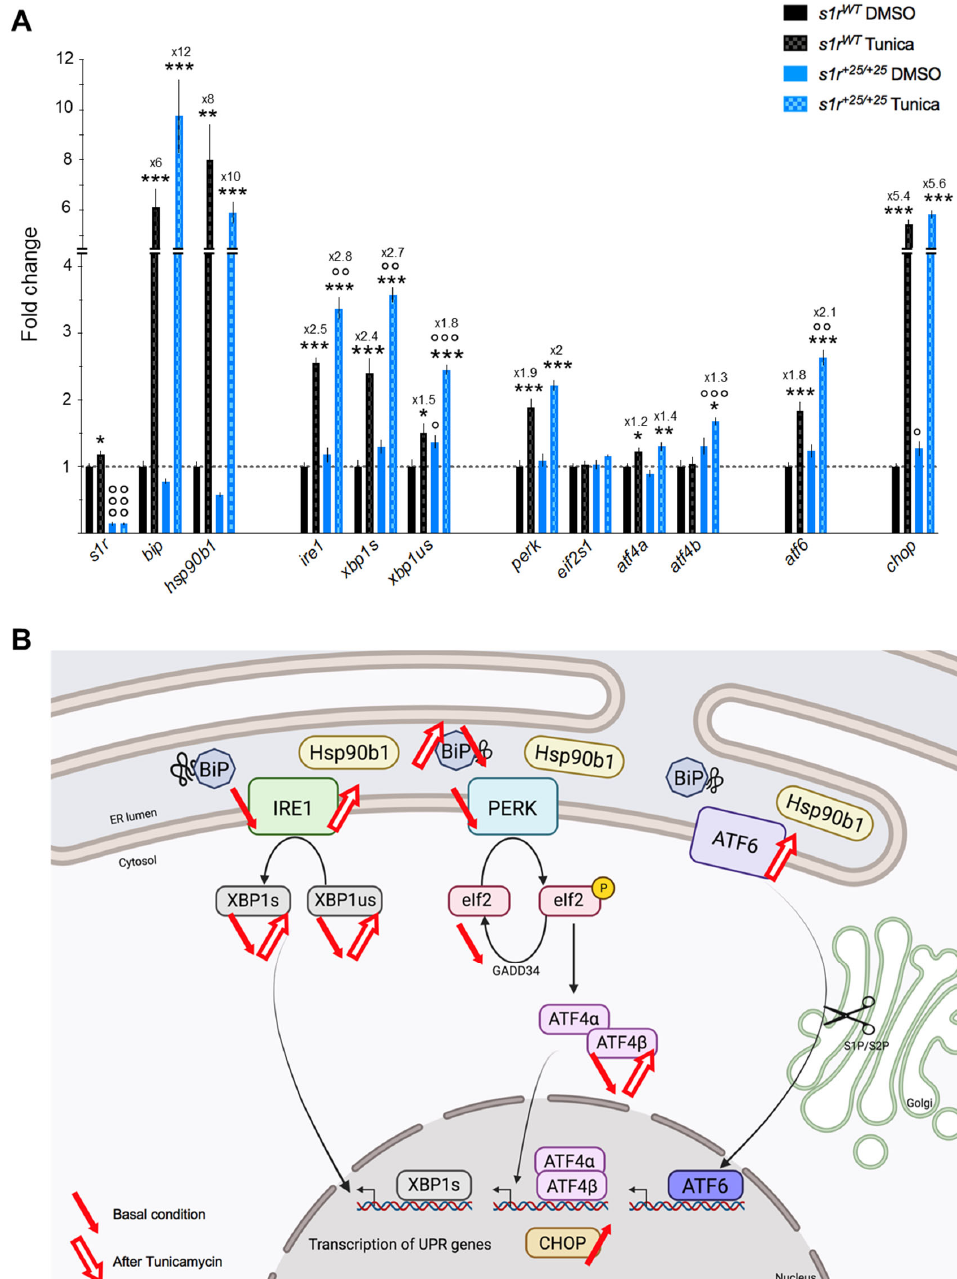
Figure 5. ( A ) Effect of the Tunicamycin (2 μ g/mL, 24 h) challenge on ER stress gene expression levels in s1r +25/+25 zebrafish larvae at 5 dpf. The selected genes were analyzed using cDNA prepared from whole zebrafish larvae and relative mRNA expression were expressed as percentage of s1r WT + 0.1% DMSO controls. The fold change from 0.1% DMSO treatment is indicated. Data are expressed in mean ± SEM of n = 5 determination in each group. * p < 0.05, ** p < 0.01, *** p < 0.001 vs. DMSO treatment; ° p < 0.05, °° p < 0.01, °°° p < 0.001 vs. s1r WT line; two ‐ way ANOVA followed by unpaired t ‐ test. ( B ) Schematic summary of ER stress pathway alterations observed in basal condition or after tunicamycin treatment in s1r +25/+25 zebrafish line.